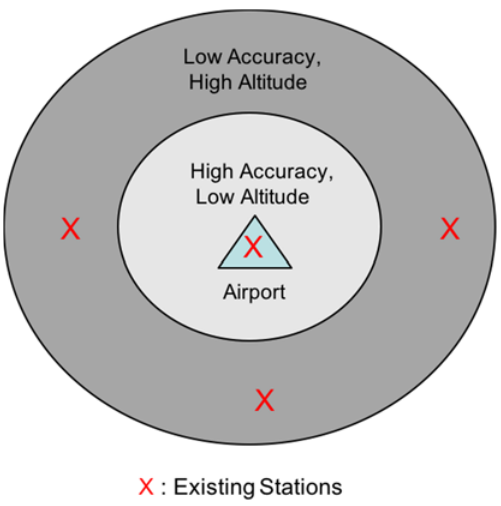
Figure 5. Station placement heuristics set-up.